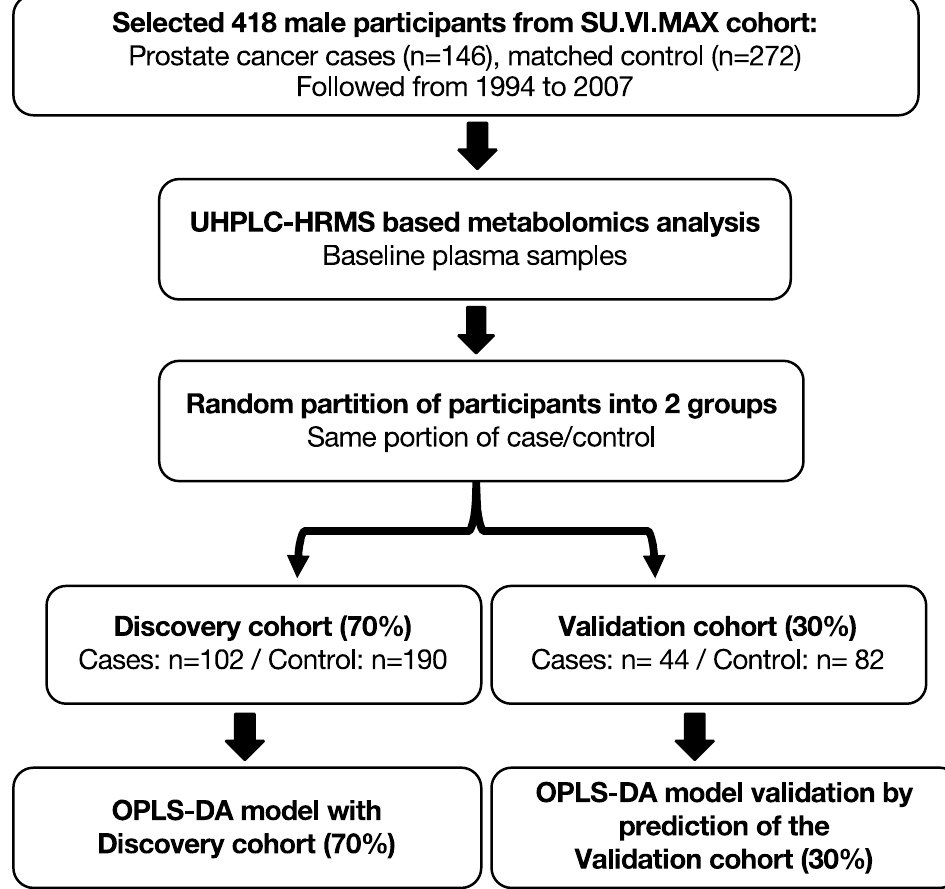
Figure 1. Simplified scheme of the study, OPLS-DA model, and validation. First, plasma samples from 418 male participants enrolled in the SU.VI.MAX cohort, which included prostate cancer cases (n = 146) and matched control (n = 272) were randomly partitioned into a discovery cohort (randomly selected 70% of all samples, with cases: n = 102/control: n = 190) and validation cohort (remaining of the cohort, 30% of all samples, with PCa cases: n = 44/control: n = 82), with an equal proportion of case/control. Then, an OPLS-DA model for classification of prostate cancer cases and matched controls was fit using the discovery cohort, the OPLS-DA model was then validated by predicting samples in the corresponding validation cohort, and an AU-ROC for prediction was calculated.